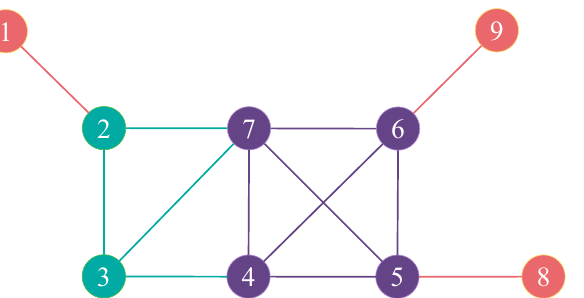
Figure 1. A toy network. The red nodes are in 1-shell, the green nodes are in 2-shell and the purple nodes are in scale-free property of networks, the index values of most nodes are relatively small. Therefore, the index with larger value space generally has a smaller ratio between the median and the maximum. In our model, it is obvious that the value space of degree centrality and eigenvector centrality is larger than that of k -shell index. In view of this, we can lower the impact of k -shell index by